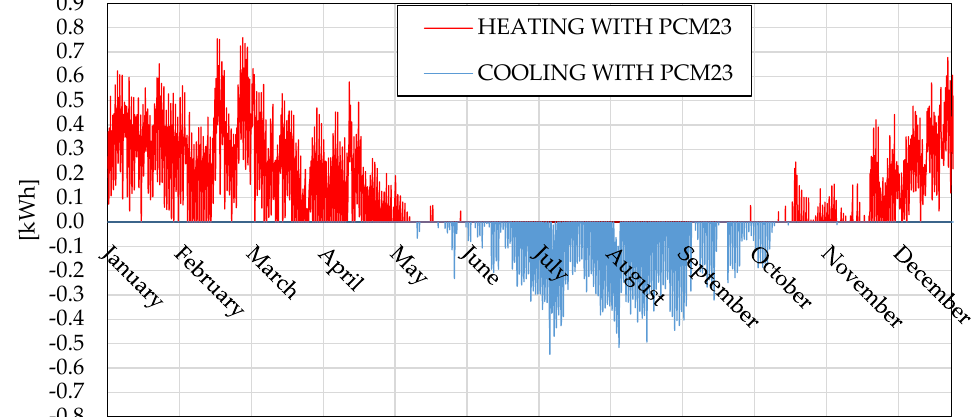
Figure 13. Hourly thermal requirements for heating (red) and cooling (blue) for CASE 2.